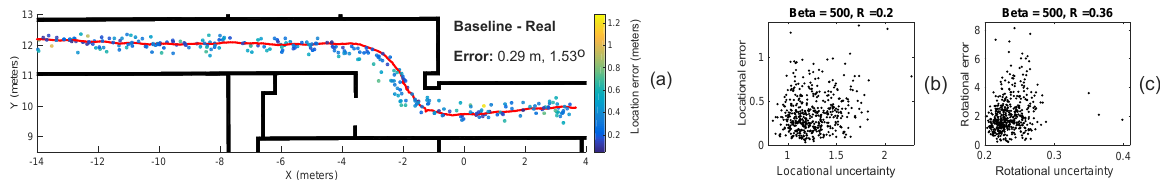
Figure 6. The variation of locational and rotational uncertainties with β . R denotes correlation coeffcient.